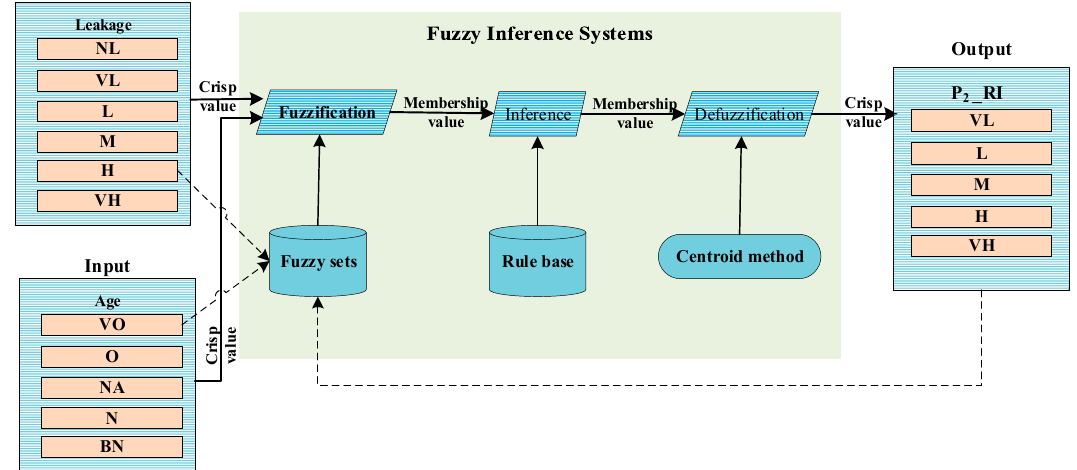
Figure 8. Structure diagram for P 2 _FIS.